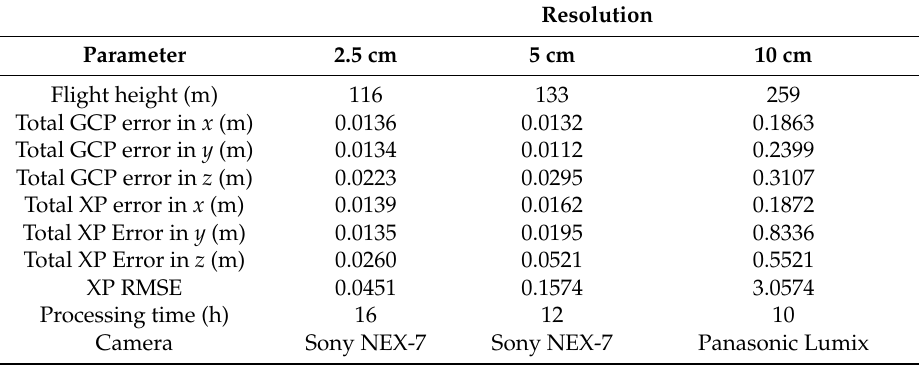
Table 3. Parameters describing the flight height, coregistration error and processing times for each of the resolutions compared. GCP, XP and RMSE stand for Ground Control Point, Check Point and Root Mean Squared Error, respectively. The processing time is the computer time required to generate the geomatic products based on the performance of a computer with an Intel Core i7-5820K 3.30